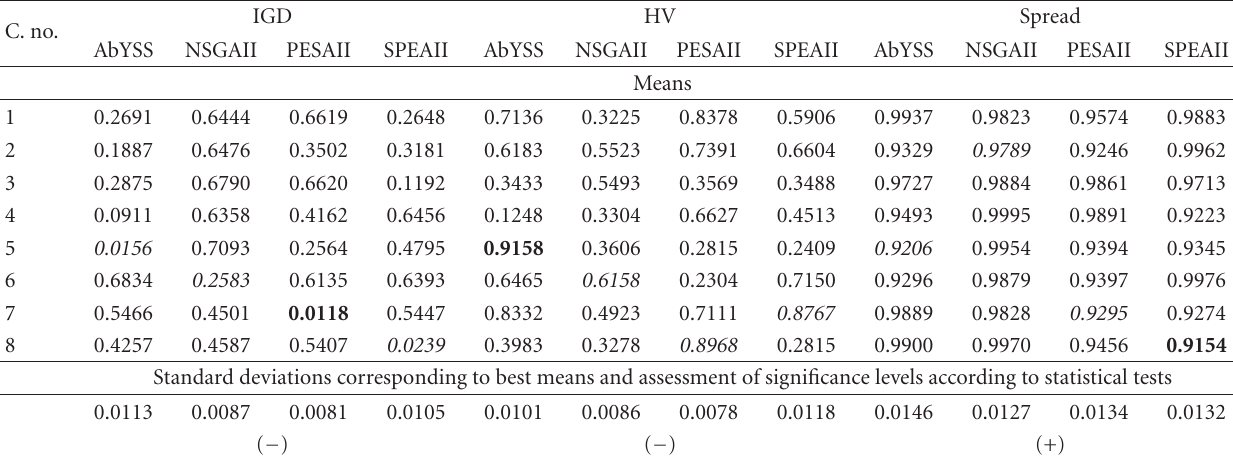
Standard deviations corresponding to best means and assessment of significance levels according to statistical tests 0.0113